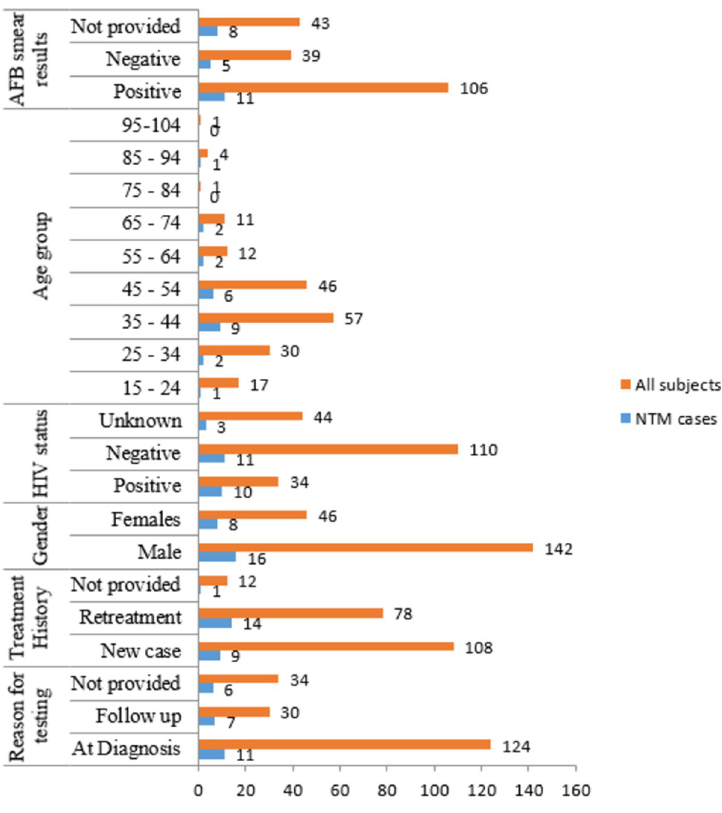
Fig 1. Variation of the number of non-tuberculous mycobacteria between various independent